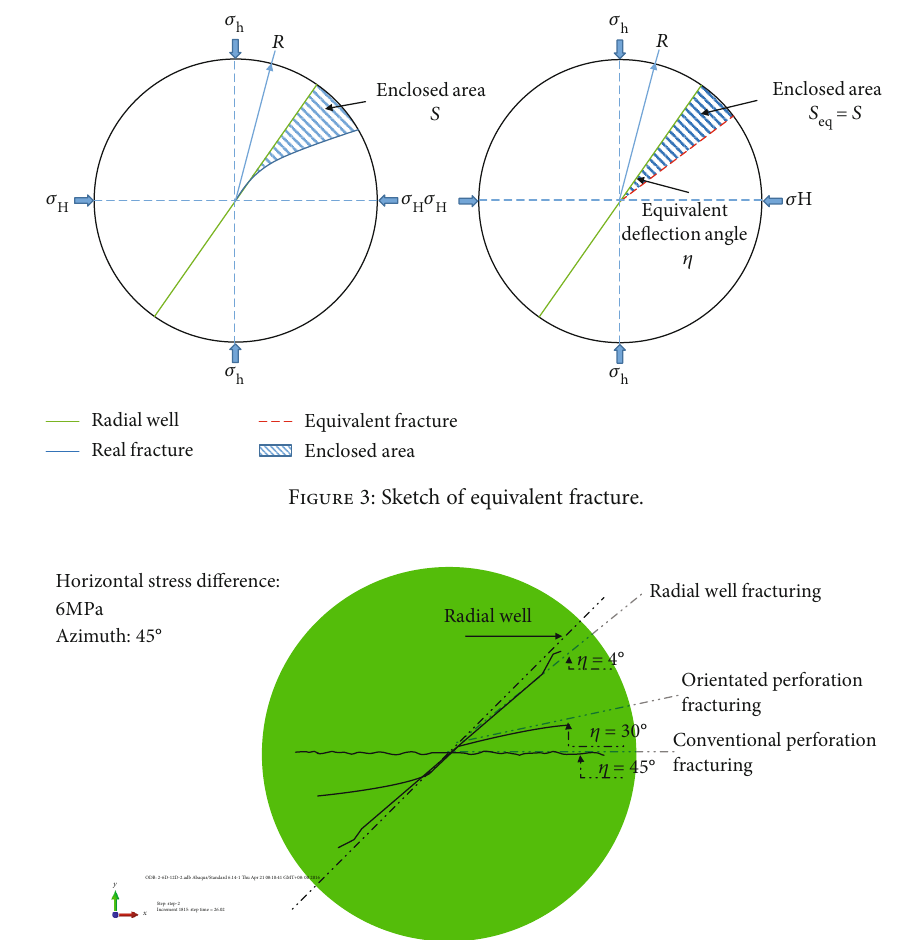
Figure 4: Simulation results of di ff erent fracture type.